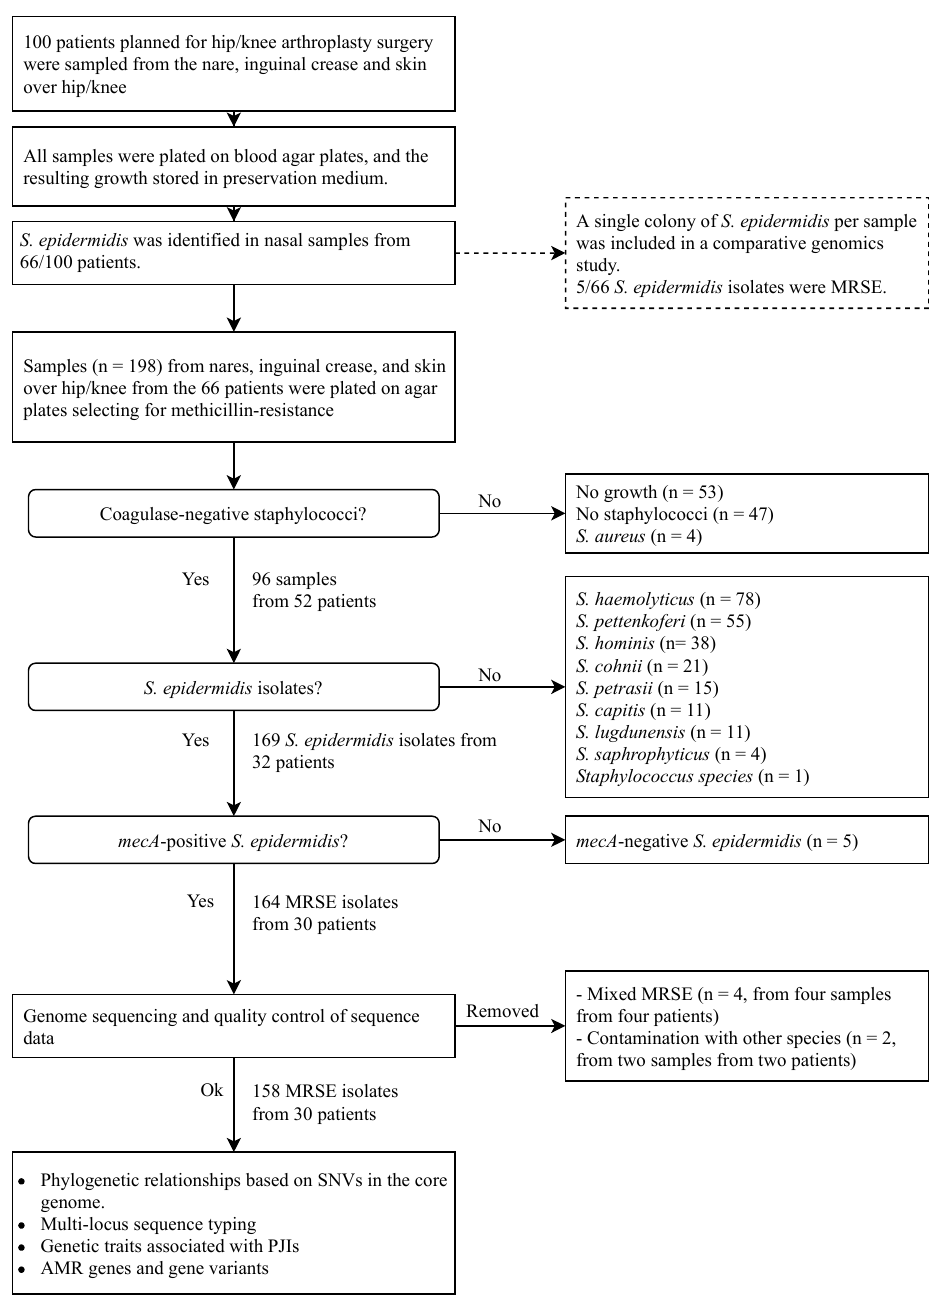
Figure 1. Origin of the isolates sequenced within this study and overview of analyses performed: one-hundred patients planned for arthroplasty surgery were sampled from their nares, inguinal creases, and skin over their hip/knee joints. S. epidermidis was retrieved from nasal samples plated on Müller–Hinton (MH) agar plates from 66 patients. A single colony of S. epidermidis was randomly chosen from the nasal sample of these 66 patients. Methicillin-resistant S. epidermidis (MRSE) was identified in samples from five out of the 66 patients. To investigate to what extent this underestimated the true colonization rate with MRSE, we plated samples from nares, inguinal creases, and skin over the hip/knee joints for these 66 patients on agar plates selecting for methicillin resistance. Coagulase-negative staphylococci were identified by colony morphology and species-determined using MALDI-TOF. The isolates identified as S. epidermidis were analyzed for the presence of mecA , and mecA -positive S. epidermidis isolates were further characterized by Illumina sequencing to determine the phylogenetic relationships, multilocus sequence types, genes associated with prosthetic joint infections (PJIs), and antimicrobial resistance (AMR) genes and gene variants.